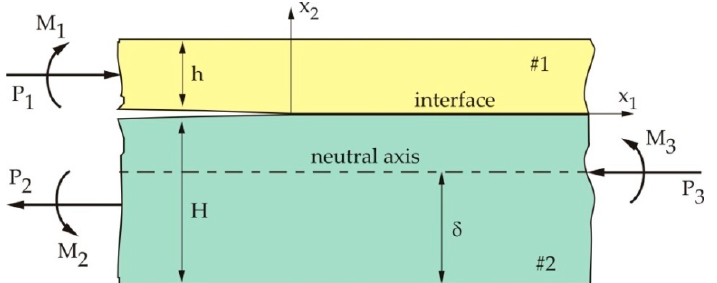
Figure 3. Semi-infinite crack at the interface between the two layers.